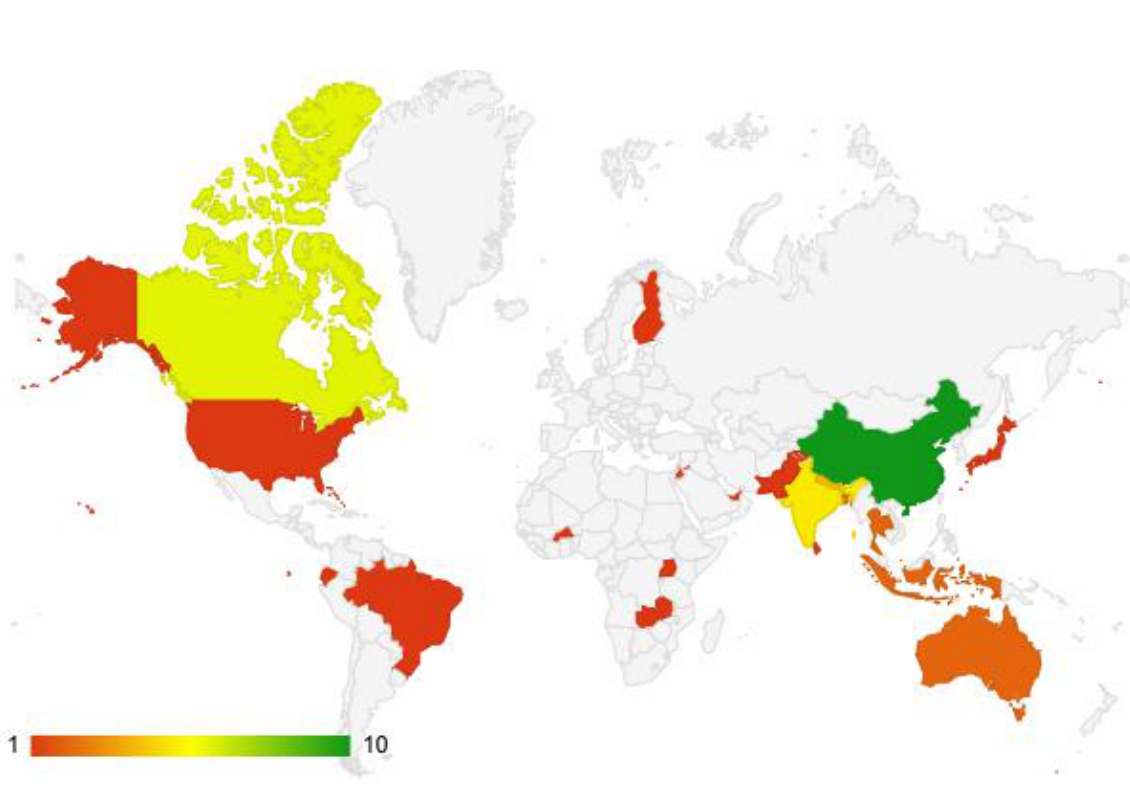
Figure 3. Systematic review by study locations